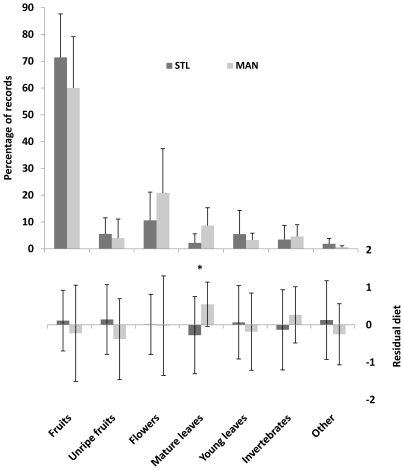
Time spent by collared lemurs eating on the various food categories at the two study sites.Upper quadrant: monthly percentages of feeding records. Lower quadrant: residuals of log-transformed feeding records controlling for log-transformed group size. Values are means and standard errors. STL: Sainte Luce; MAN: Mandena; * p<.05.